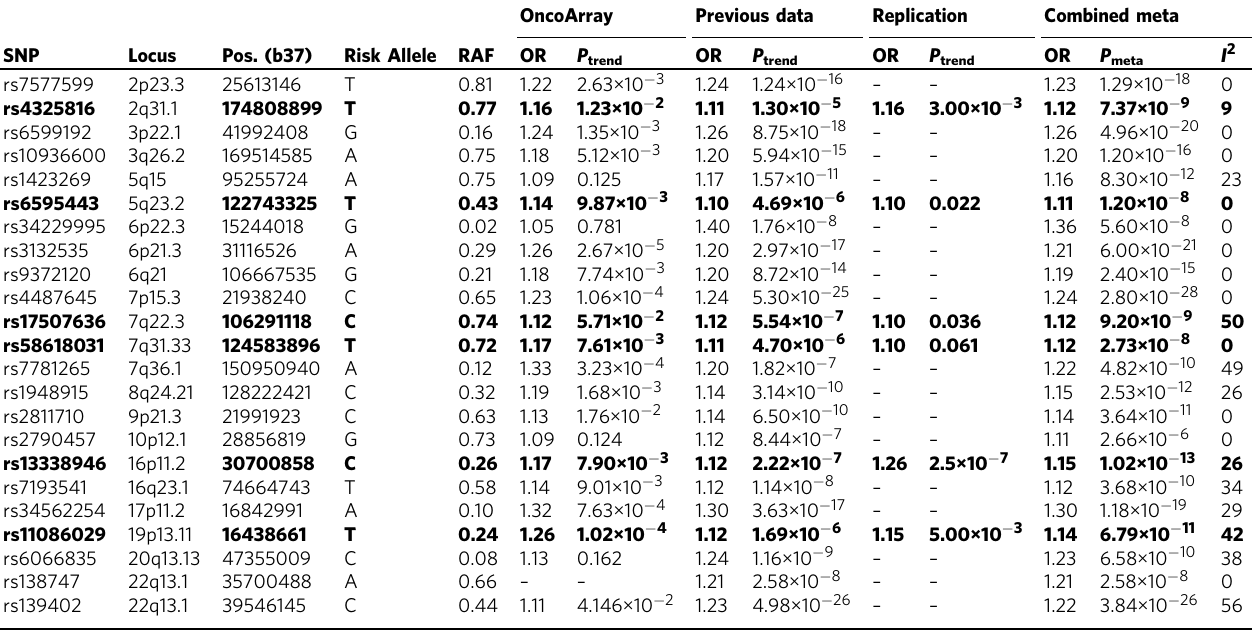
Table 1 Summary of genotyping results for all 23 risk SNPs